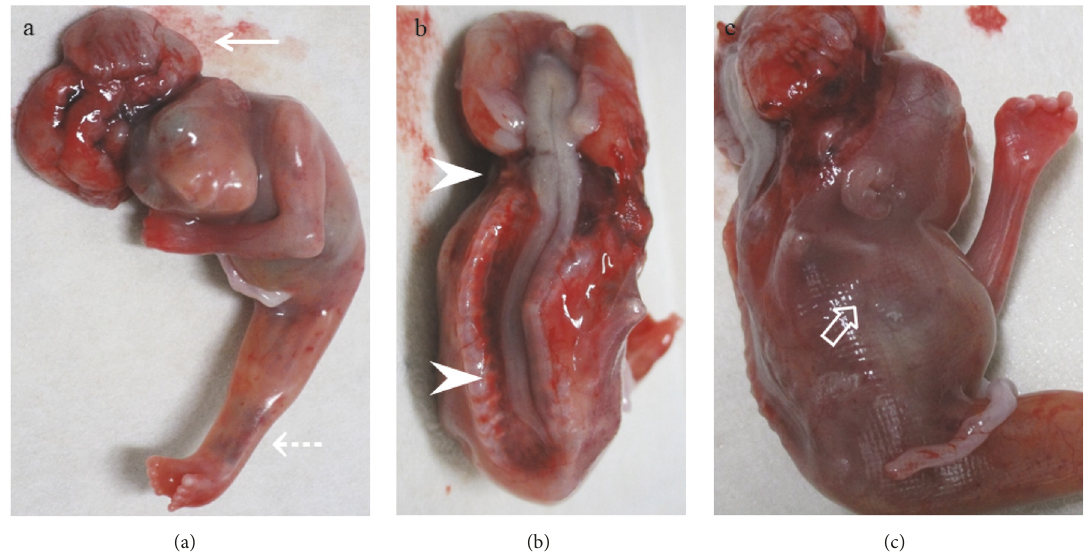
Figure 3: Macroscopic views of the aborted fetus. (3a) External examination of the fetus showed anencephaly (white arrow), fused lower limbs, and nine toes with a fused bilateral thumb (white dashed arrows). (3b) Craniorachischisis totalis (white arrowheads). (3c) Absence of the right upper limb (white open arrow).